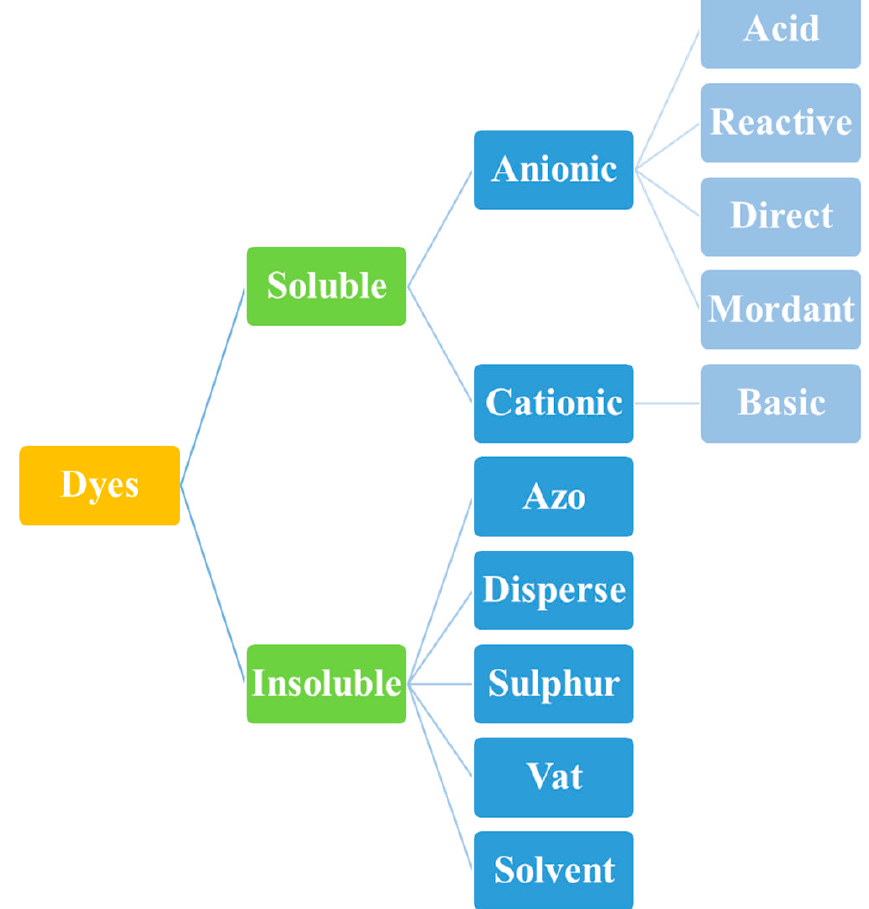
Figure 1. Types of dyes based on their adopted from Shamsani et al., 2020 [5] with permission.